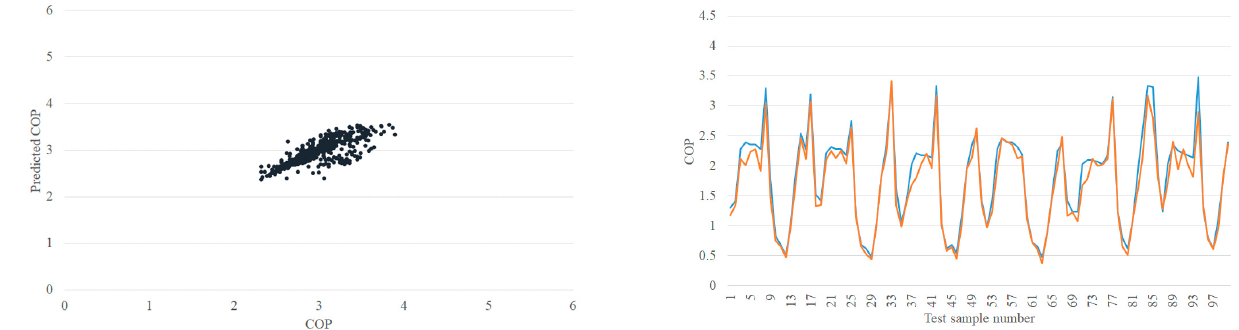
Figure 6. Comparison of predicted and measured performance using SVM model.